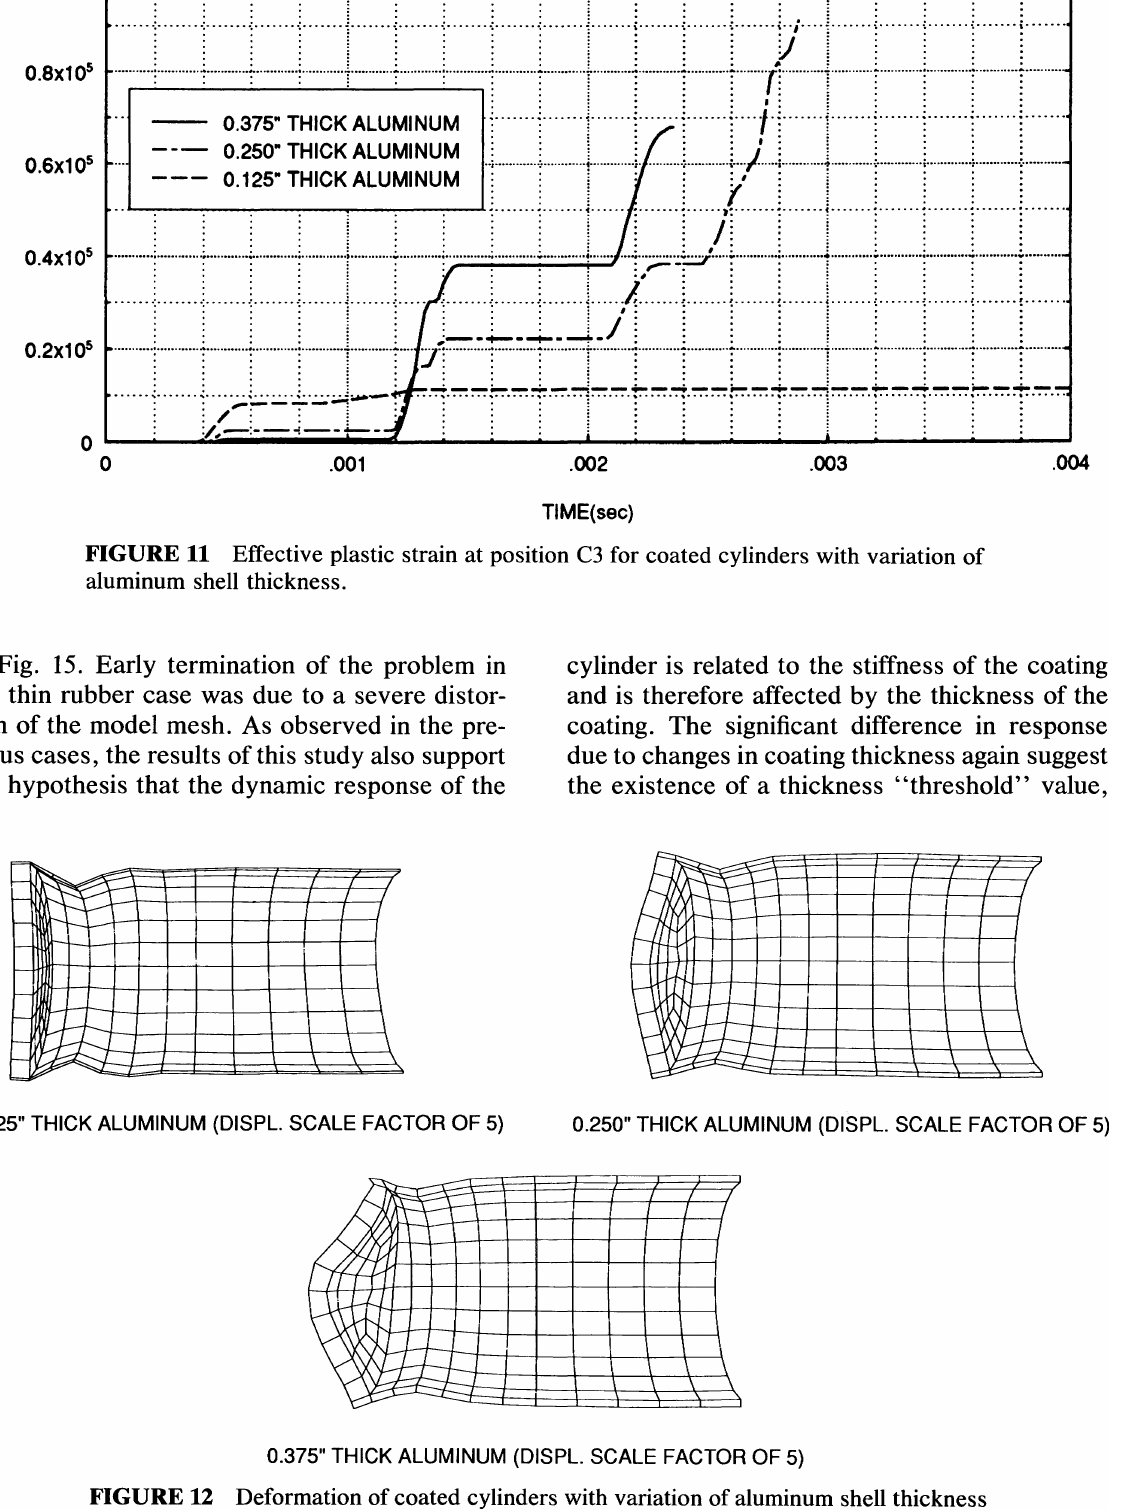
FIGURE 12 Deformation of coated cylinders with variation of aluminum shell thickness at 2.34